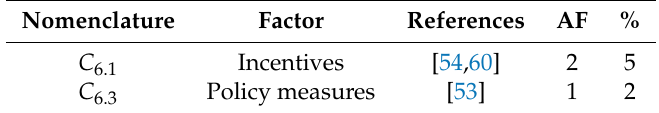
Table 18. Political Category ( C 6 )—Offshore wind energy. Quantitative